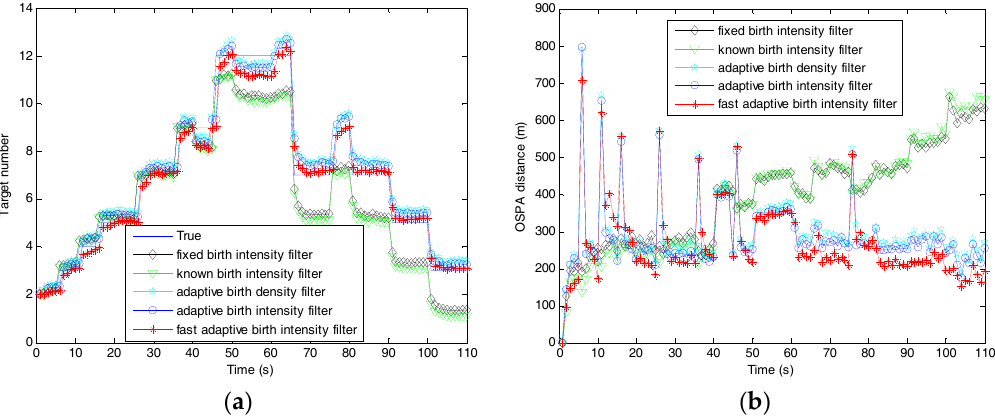
Figure 13. Tracking performance of the fast adaptive target birth intensity CBMeMBer filter and other CBMeMBer filters with different target birth models in the case of continuously missing detections: ( a ) target number estimation; ( b ) OSPA distances.